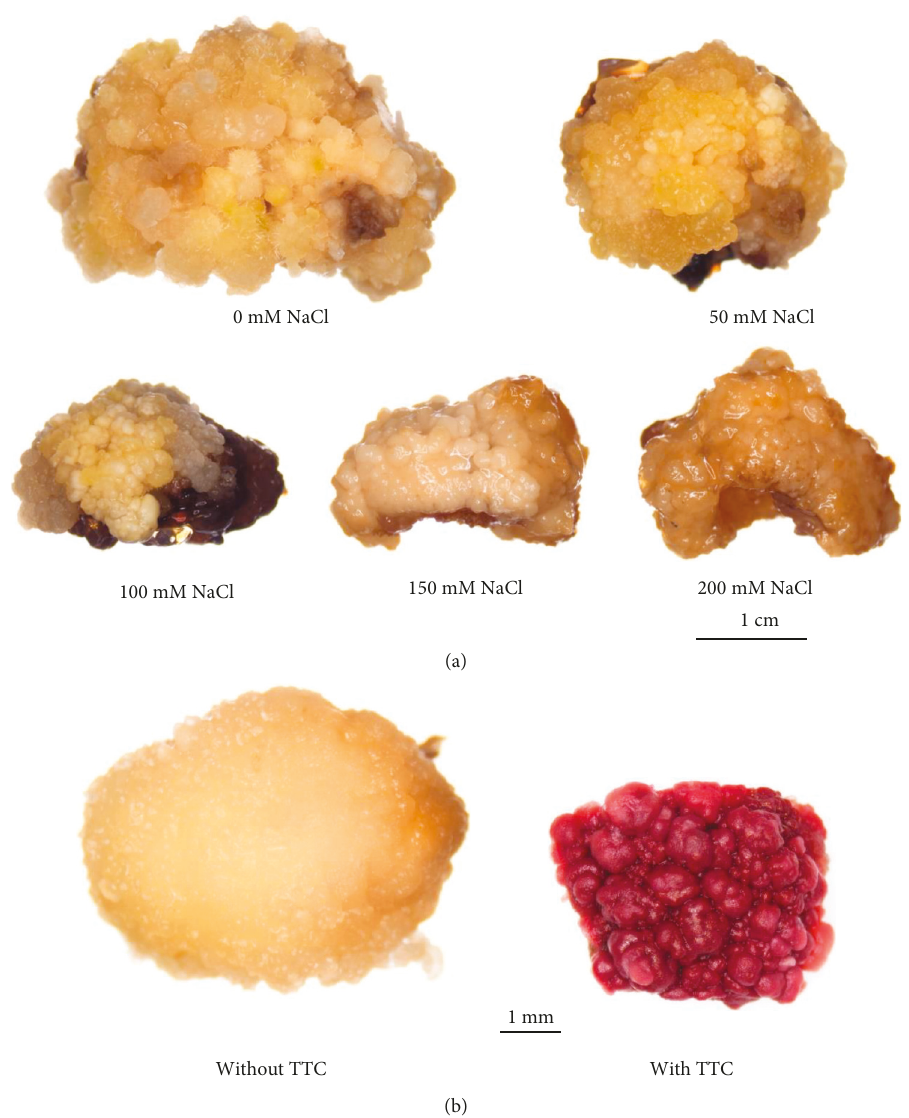
Figure 4: Callus features after culture on MS medium supplemented with 0.5mg/l BA, 1 mg/l NAA, and various concentrations of NaCl for four weeks (a). Living tissue tested with TTC assay showed red compared to colorless living tissue without TTC assay (b).